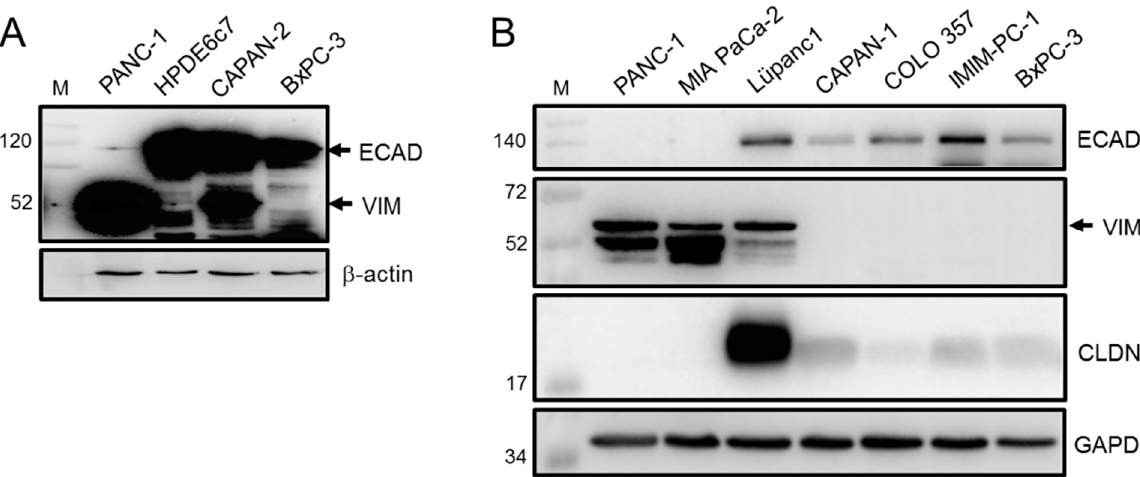
Figure 1. Expression of epithelial and mesenchymal markers in PDAC-derived tumor cell lines as measured by immunoblot analysis. ( A ) The indicated PDAC cell lines, and HPDE6c7 cells as control, were immunoblotted for ECAD and VIM. Equal loading was verified by detection of β -actin. The blot was overexposed to also catch the weak ECAD band in PANC-1 and the lack of VIM signals in HPDE6c7 and BxPC-3 cells. For a short exposure copy of this blot see Figure S1A. ( B ) As in ( A ) except that additional PDAC cell lines were analyzed for ECAD, VIM, CLDN4. Detection of GAPDH served as a loading control. In lysates from COLO 357 cells a band for VIM becomes visible upon longer exposure of the blot (not shown).